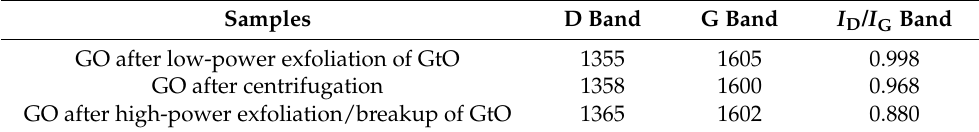
Table 3. Position of the band (cm − 1 ) from Raman to GO after low-power exfoliation, GO after centrifugation and GOn after high-power exfoliation/breakup pf GtO and respective I D /I G band ratios. Samples D Band G Band I D / I G Band GO after low-power exfoliation of GtO 1355 1605 0.998 GO after centrifugation 1358 1600 0.968 GO after high-power exfoliation/breakup of GtO 1365 1602